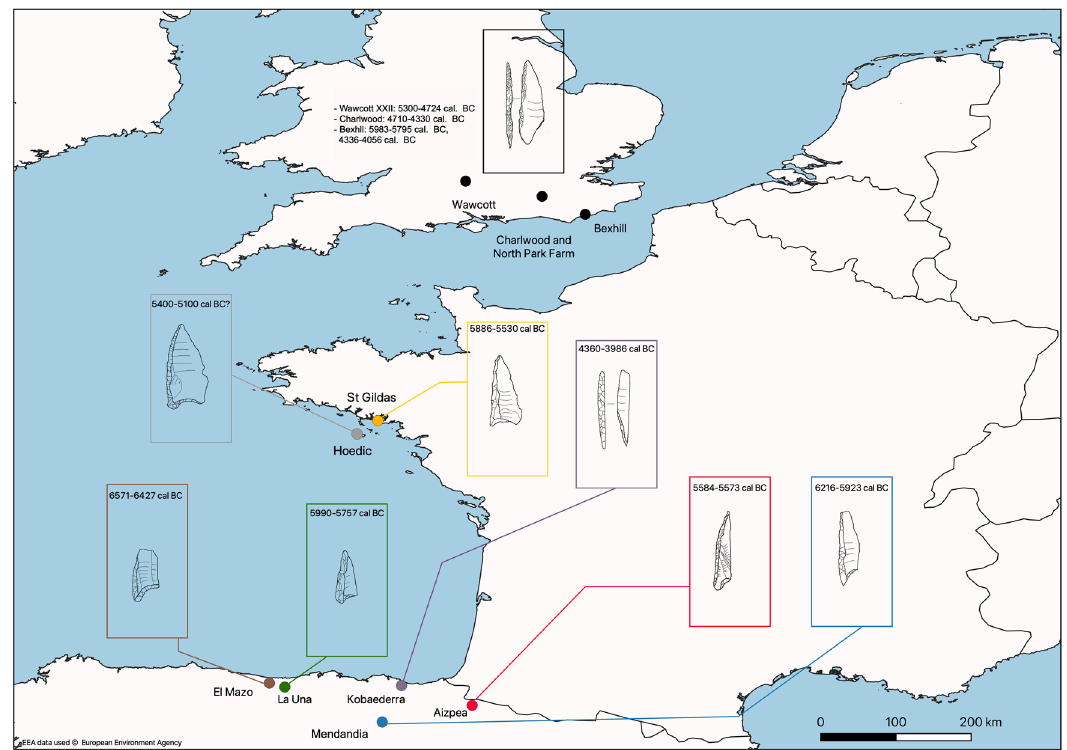
Figure 8: Location and dates of the Bexhill - esque points from N. Spain and NW France. Note that the points from Hoëdic and Saint Gildas are speculative because of a lack of contextual information and the reservoir e ff ect. Redrawn from: ( Alday, 2014; Alday & Cava, 2008; Campos et al., 2016; Cubas et al., 2016; Dupont et al., 2007; Ellaby, 2004; Fuertes - Prieto et al., 2021; Jones, 2013; Péquart & Péquart, 1954 )